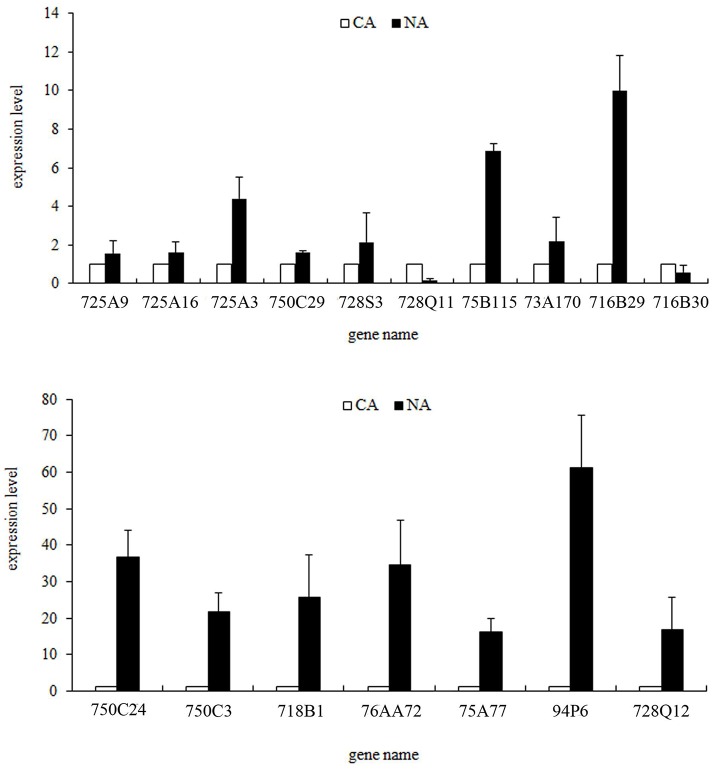
qRT-PCR confirmation of the expression profiles of some randomly selected CYP450 genes. Fold changes of transcript levels in CA and NA are shown. Error bars indicate the mean (SEM).